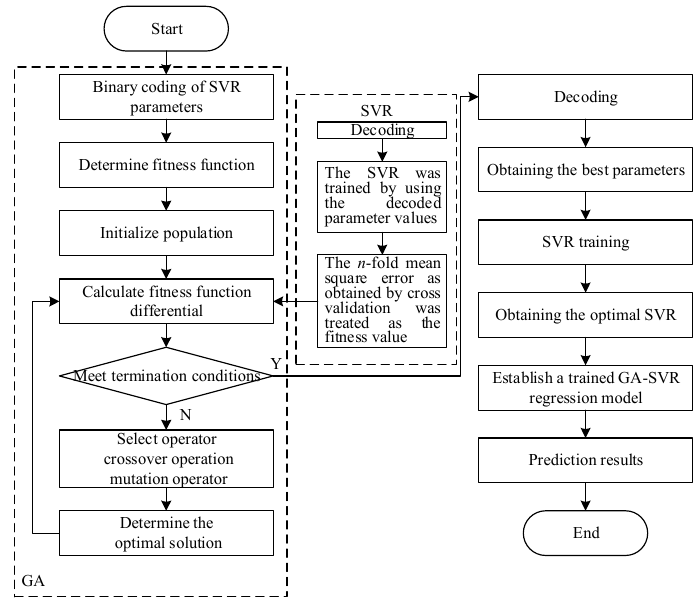
Figure 1. Flowchart of GA ‐ SVR prediction model .